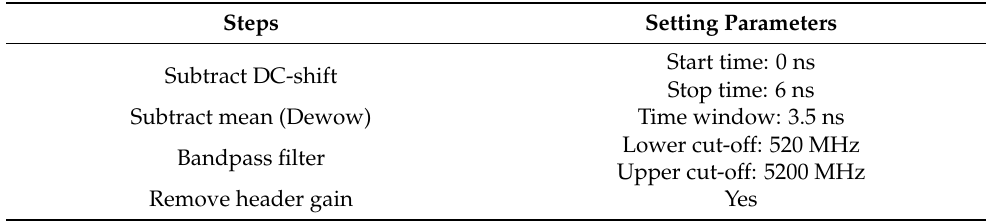
Table 2. Pre-processing steps performed on 2.6 GHz GSSI